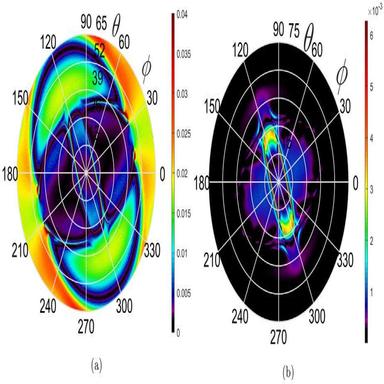
Difference TOF P-UPS plot (a) and difference amplitude P-UPS plot (b) displaying the absolute value of the difference between the forward P-UPS simulation based on the actual viscoelastic constants and the simulation using the inverted elastic and viscoelastic constants of respectively stage I and II. The colorbar of the TOF differences is expressed in μs. The amplitude differences are expressed in V, where 1 V refers to the maximum amplitude value of the signal.